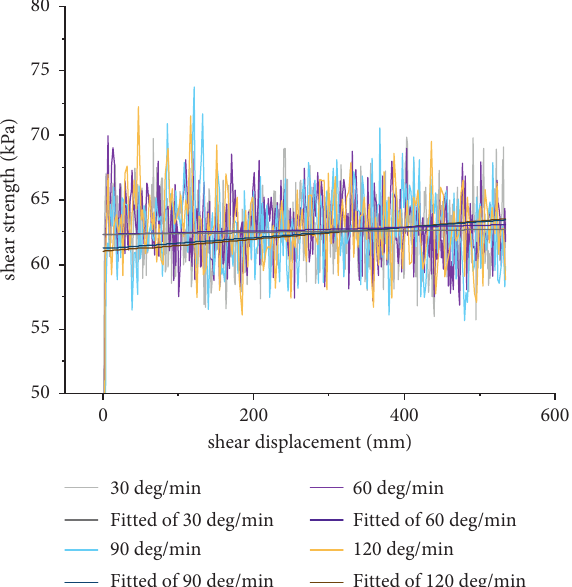
Figure 3: Shear stress-displacement curves under different normal stresses.